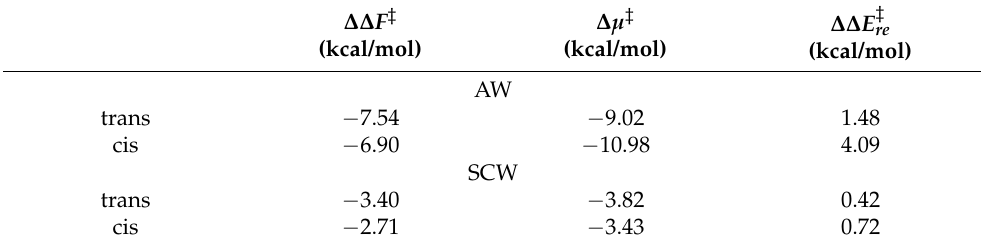
Table 1. The change in the activation free energy from the gas phase to AW and to SCW. This table is reprinted with permission from JACS , 2000 , 122 , 2289. Copyright 2000 American Chemical Soci- ety.